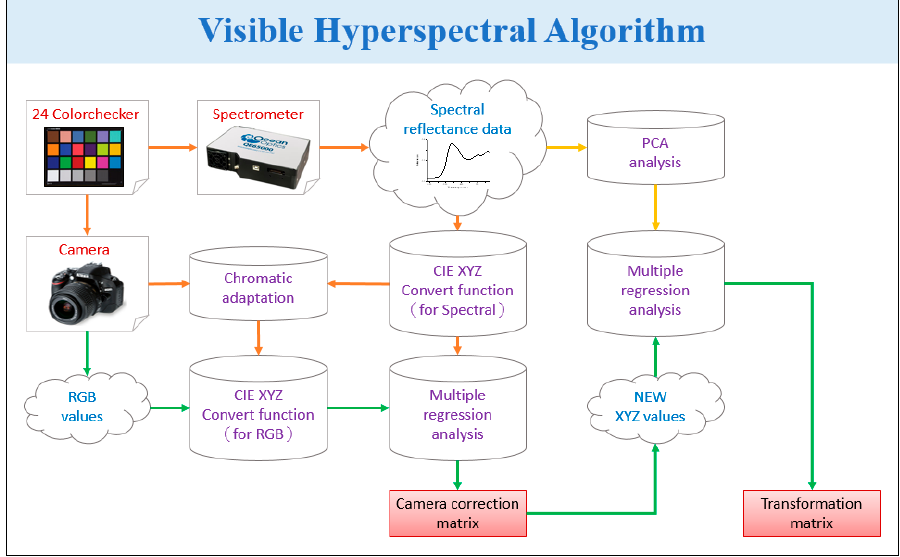
Figure 1. Visible Hyperspectral Imaging Algorithm.